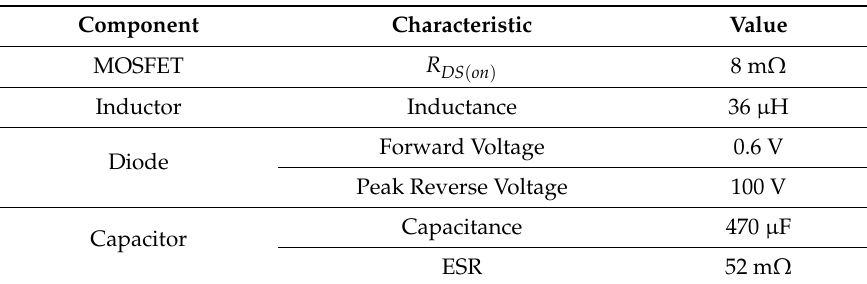
Table 5. Boost converter component values.